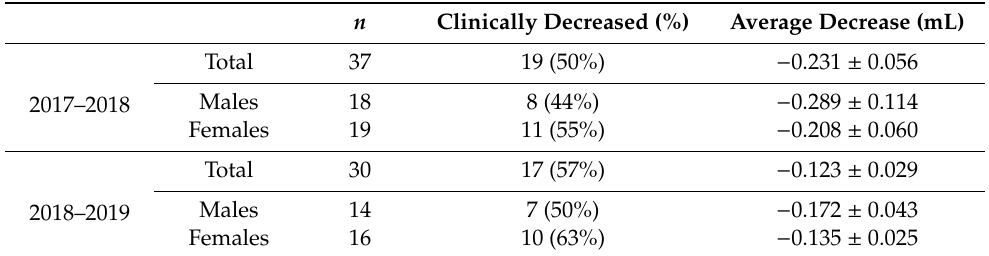
Table 2. Annual change of FEV 1 in Seeley Lake cohort—males vs. females. n Clinically Decreased (%) Average Decrease (mL)